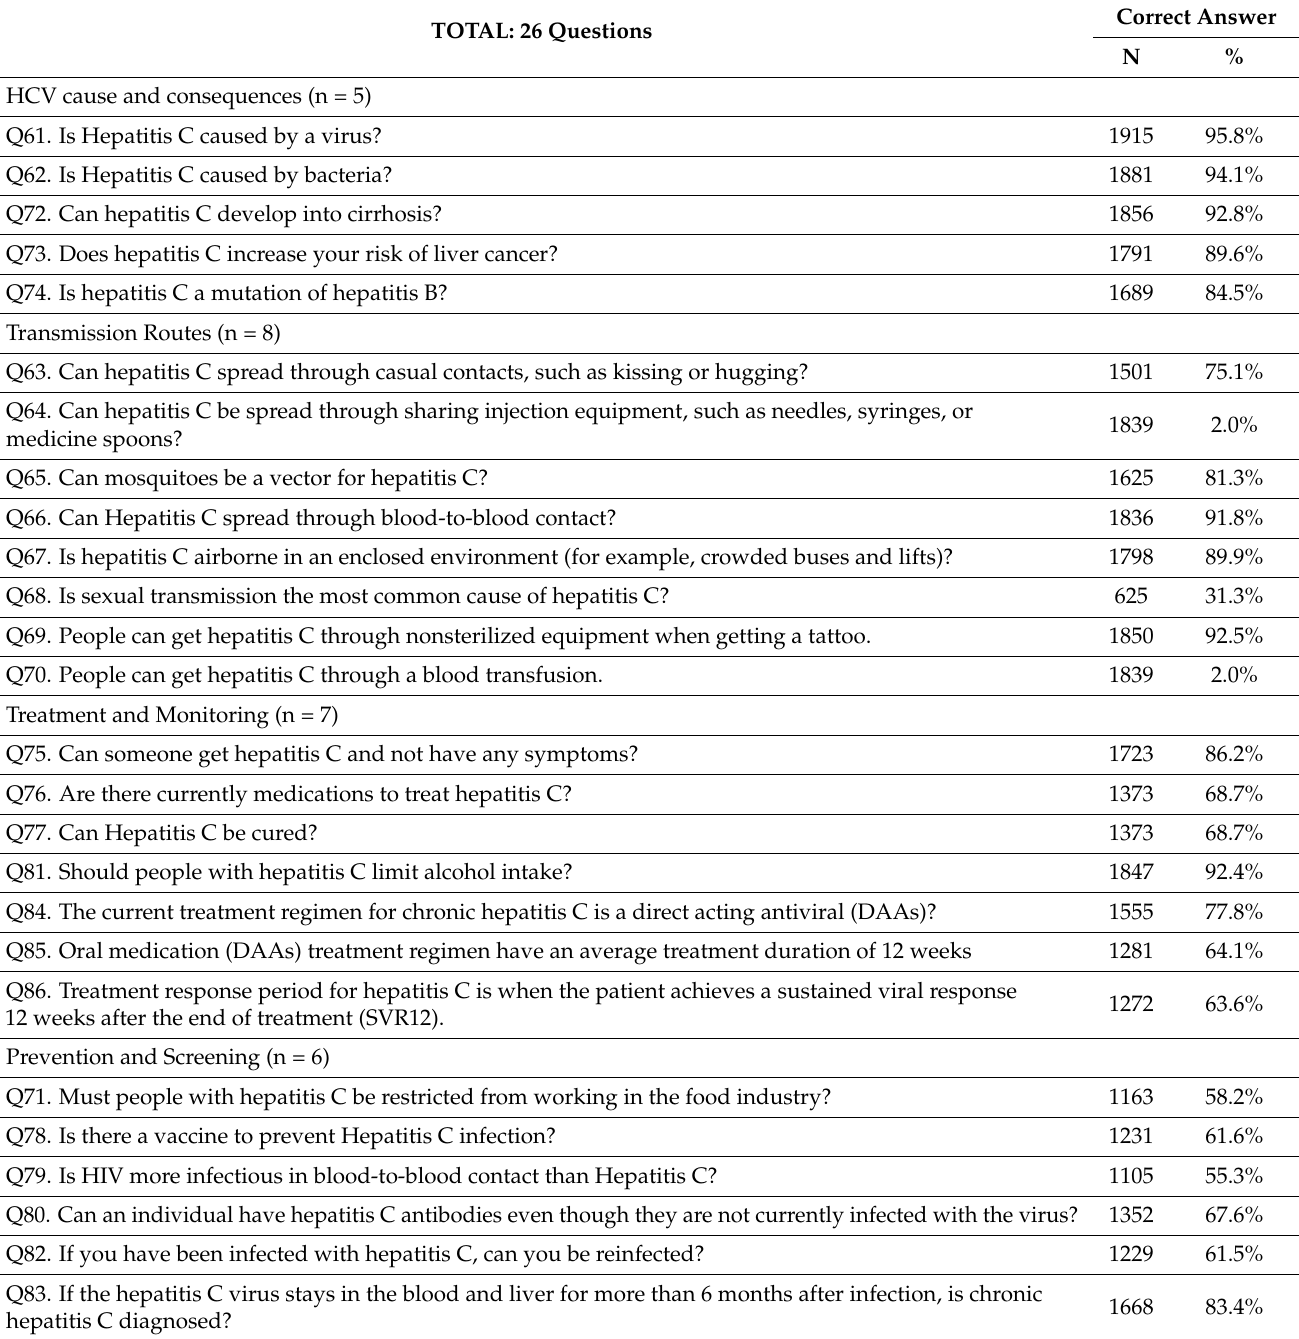
Table 1. Correct knowledge answers toward HCV (n =